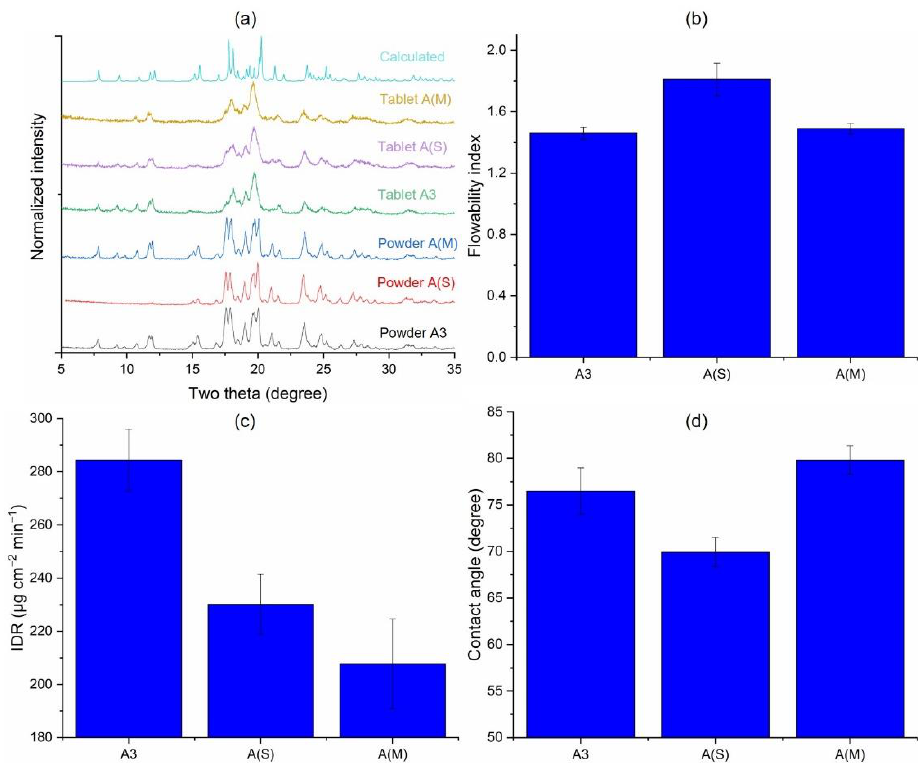
Figure 9. Solid-state characterization, bulk properties of Samples A3, A(S) and A(M). ( a ) X-ray diffraction; ( b ) flowability; ( c ) intrinsic dissolution rate; ( d ) contact angle.